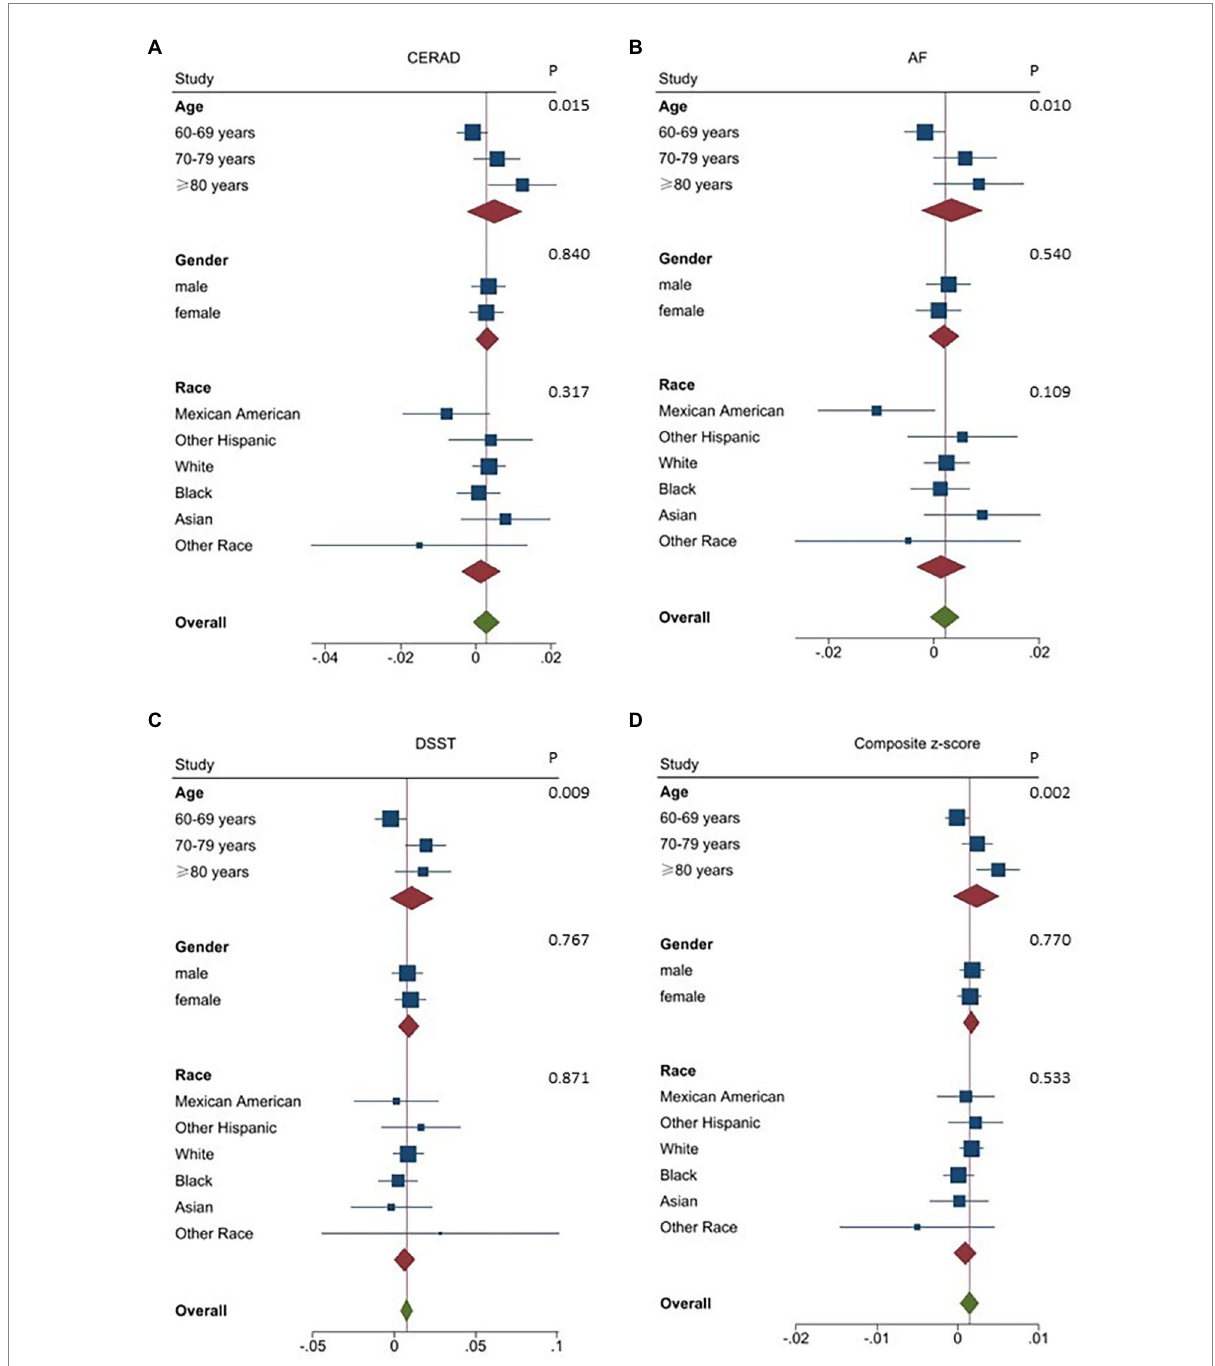
FIGURE 3 Association between SUA and various domains of cognitive function stratified by demographic characteristics. Age, gender, race, education, marital status, ratio of income to poverty, albumin, creatinine, body mass index, diabetes, heart failure, stroke, hypertension, alcohol consumption, and physical activity were adjusted. In the subgroup analysis stratified by age, gender, and race, the model is not adjusted for age, gender, or race, respectively. (A) Association between SUA and CERAD stratified by demographic characteristics. (B) Association between SUA and AFstratified by demographic characteristics. (C) Association between SUA and DSST stratified by demographic characteristics. (D) Association between SUA and Composite z-score stratified by demographic characteristics. CERAD: Consortium to Establish a Registry for Alzheimer’s Disease; AF: Animal fluency test; DSST: Digit symbol substitution